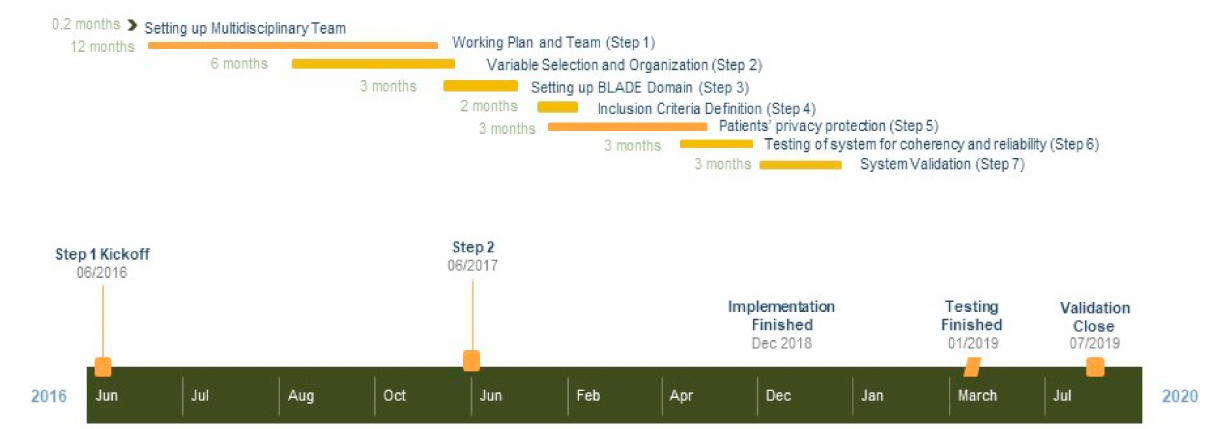
Figure 2. Timeline framework for ATTM.BLADE